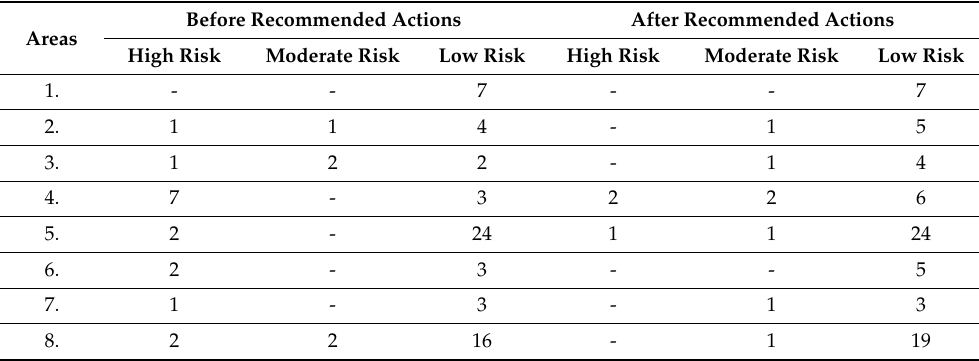
Table 7. Number of risks in each area according to the RPN value before and after the recommended